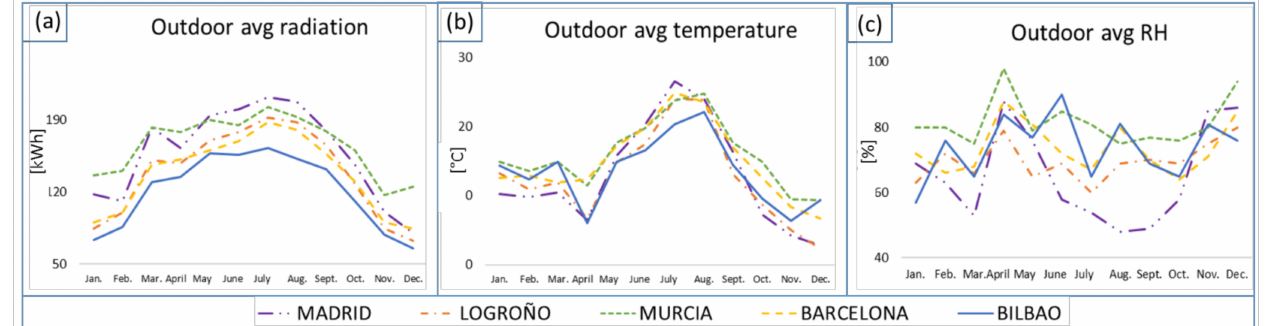
Figure 12. Average ( a ) radiation ( b ) temperature and ( c ) relative humidity of the 5 cities.